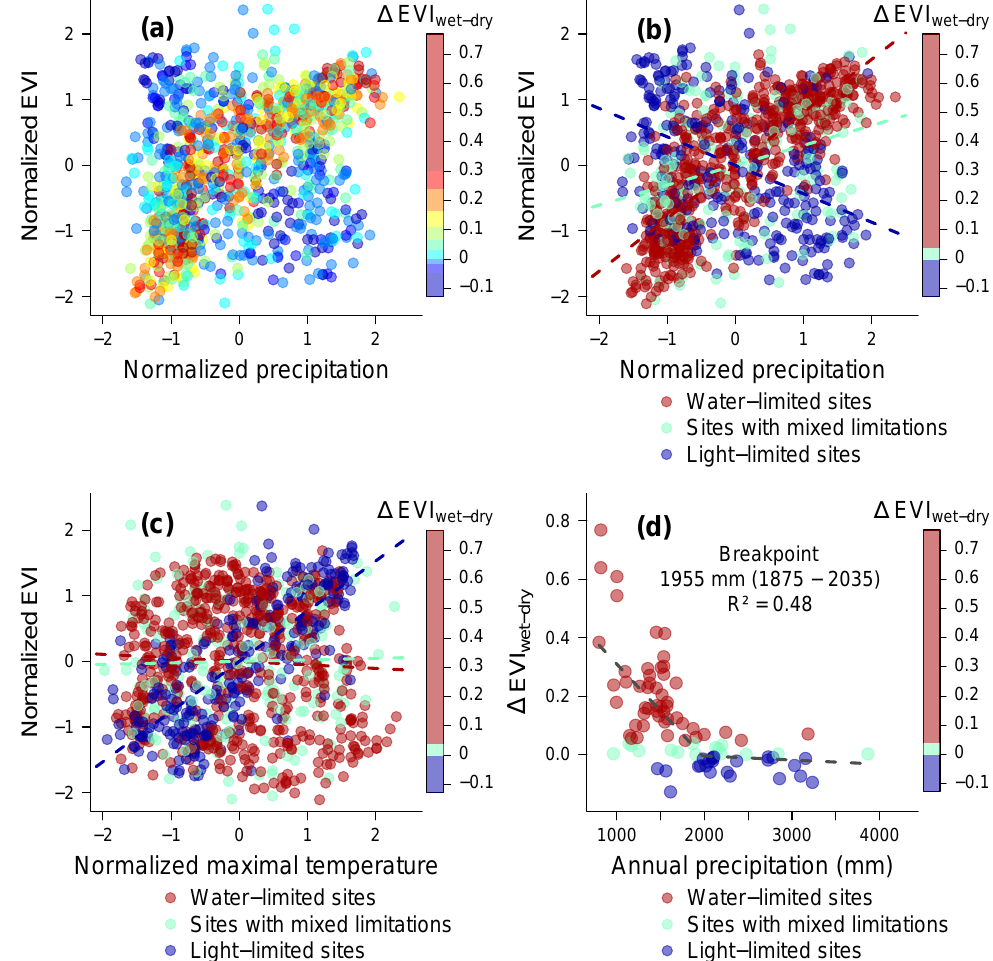
Figure 5. Monthly associations of EVI with precipitation (a, b) , maximal temperatures (c) , and association of (cid:49) EVI wet-dry with mean annual precipitation (d) . In (a) colours represent the value of (cid:49) EVI wet-dry while in (b) , (c) and (d) colours represent (cid:49) EVI wet-dry grouped by the following classes : water-limited sites ( (cid:49) EVI wet-dry > 0 . 0378), sites with mixed limitations ( (cid:49) EVI wet-dry [ − 0.0014; 0.0378]) and light-limited sites ( (cid:49) EVI wet-dry < − 0 . 0014). The dashed lines in (b) and (c) represent the linear relationship between climate variable and observed EVI for water-limited sites, sites with mixed limitations and light-limited sites. Parameters of the models are given in Table S8. The dashed lines in (d) represents the best regression model with a breakpoint between (cid:49) EVI wet-dry and mean annual